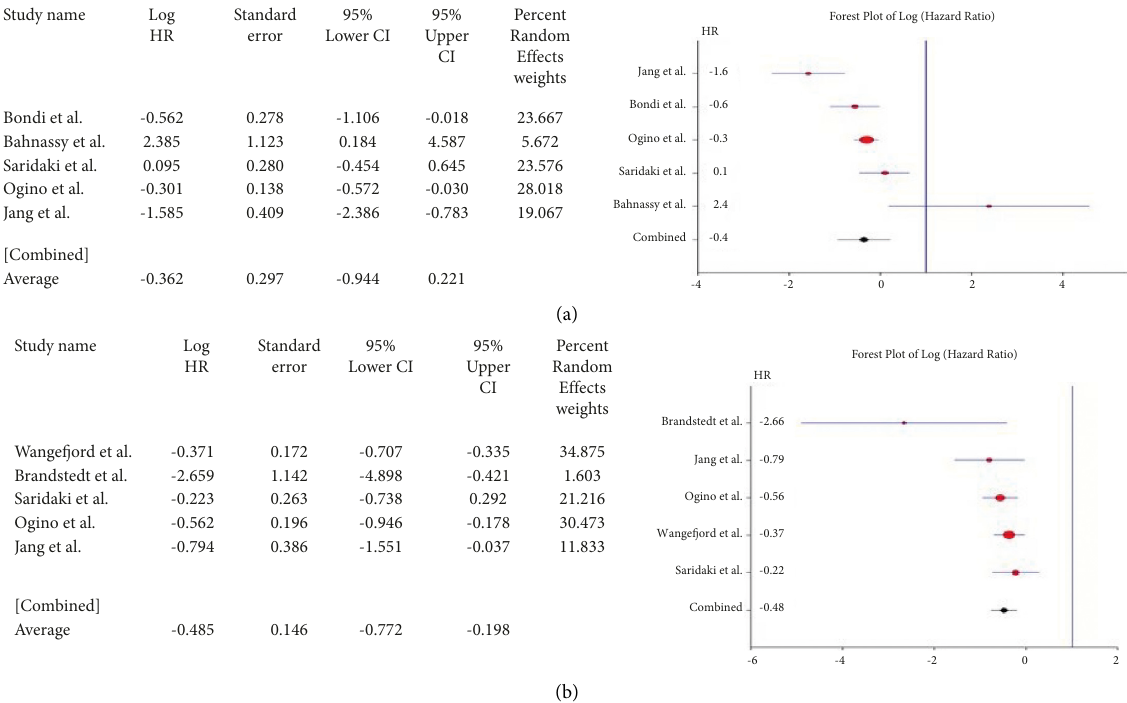
Figure 7: Forest plot of Cyclin D1 gene and overall survival in CRC (a). Forest plot of cyclin D1 gene and disease-free survival in CRC (b).